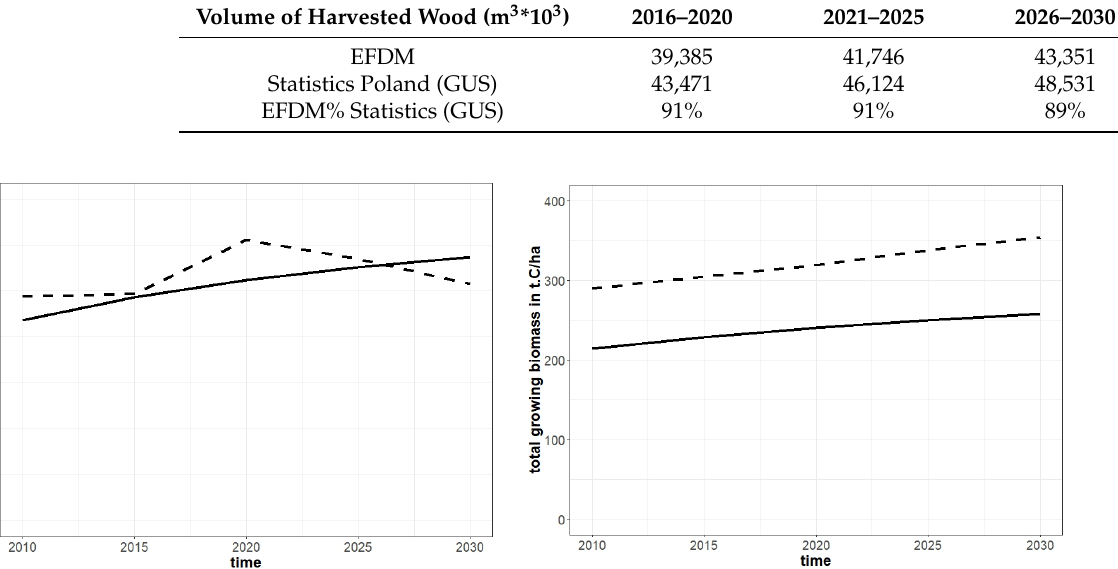
Figure 8. Total growing biomass calculated by both tools, reported in t.C. 106 (on the left ) and t.C.*ha − 1 (on the right ). EFDM projections represented by dashed line, CBM-CFS3—solid line.